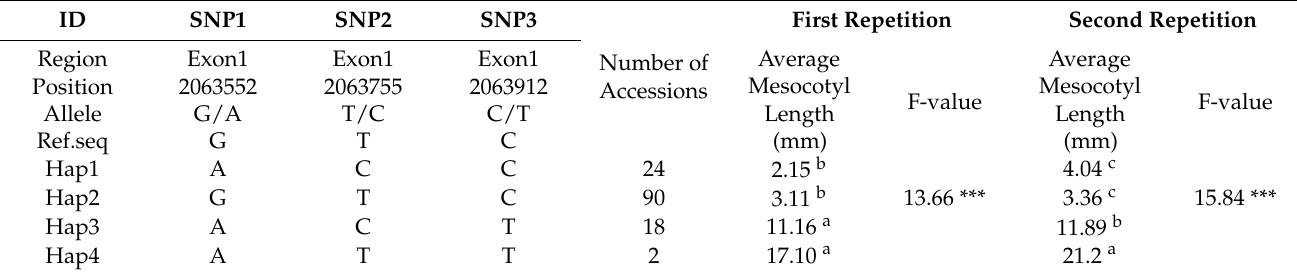
Hap: Haplotype. Letters: a, b, c represent different significance level at *** p < 0.001 (Duncan’s